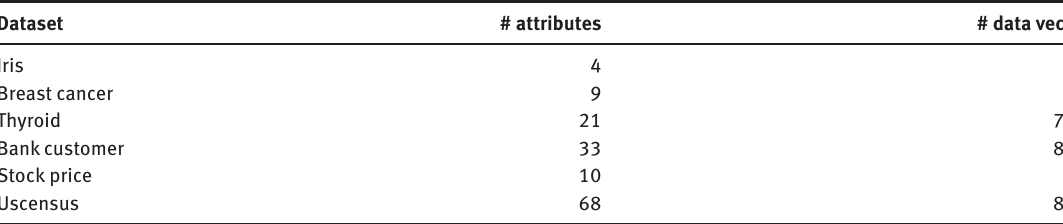
Table 1: Datasets Used for